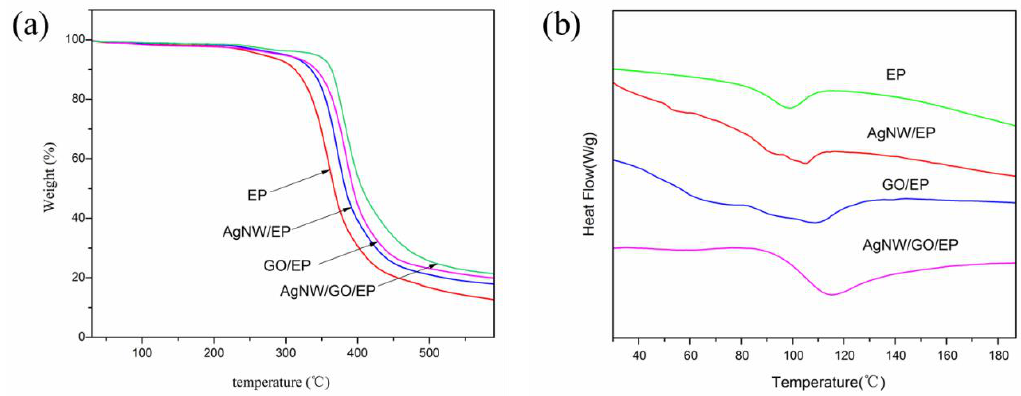
Figure 9. ( a ) TGA and ( b ) DSC curves of EP, AgNW / EP, GO / EP, and AgNW / GO / EP composites. Table 2. TGA data of EP, AgNW / EP, GO / EP, and AgNW / GO / EP composites. Sample T 5% ( ◦ C) T 50% ( ◦ C)